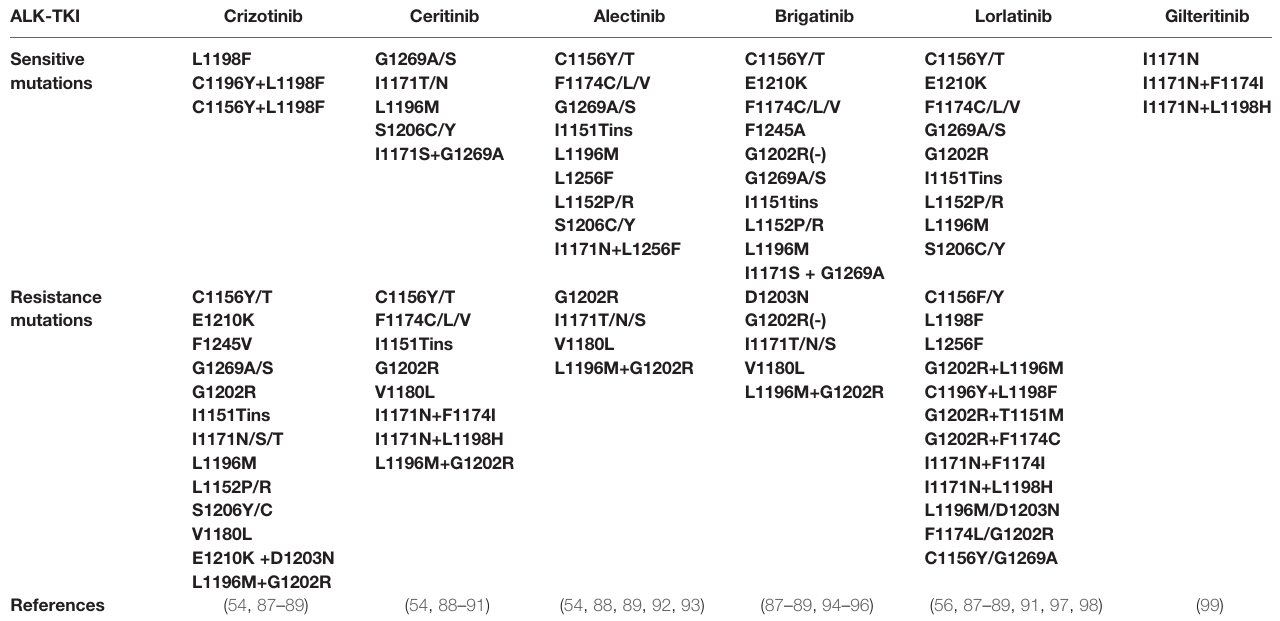
TABLE 1 | Resistant and sensitive mutations of